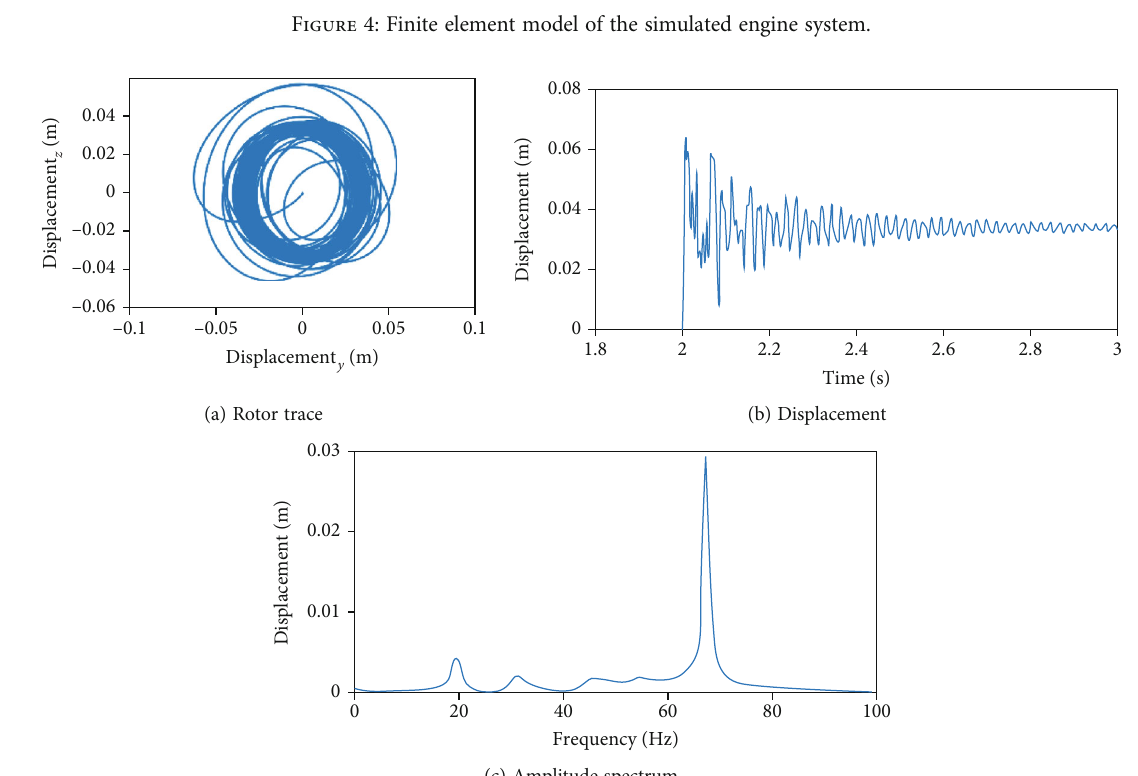
Figure 5: Response of the low-pressure compressor disk in the simulated aeroengine system.